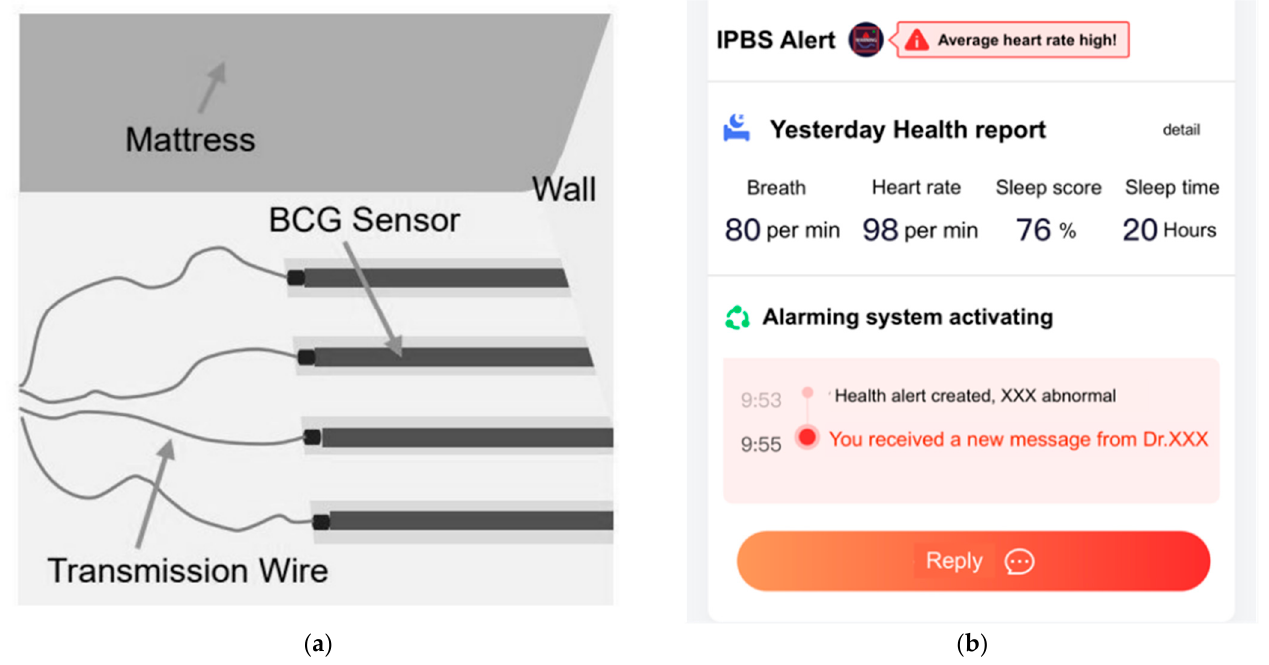
Figure 7. Online sleep monitoring platform: ( a ) sensor, ( b ) interface